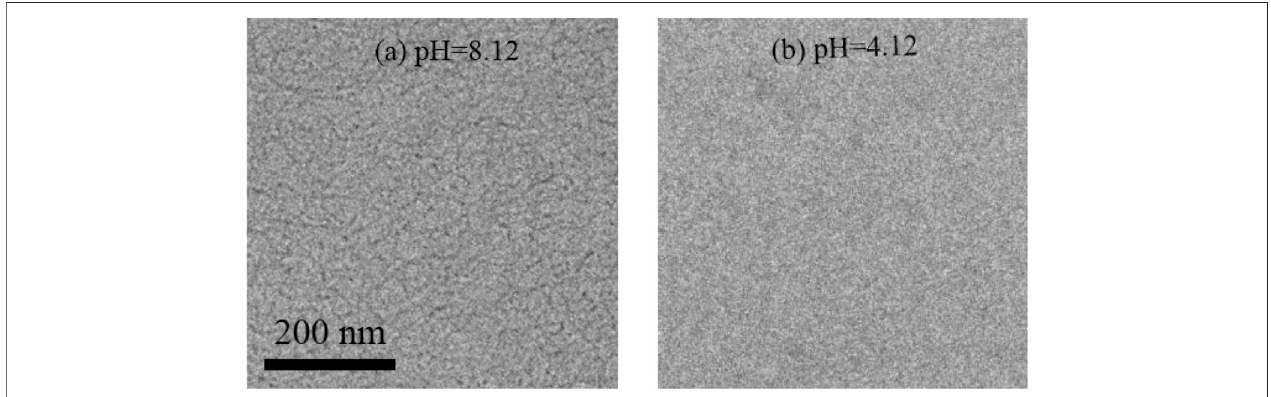
FIGURE 10 | The micromorphology of the MSA/CTAB mixed solution at pH = 8.12 (A) and pH = 4.12 (B) .